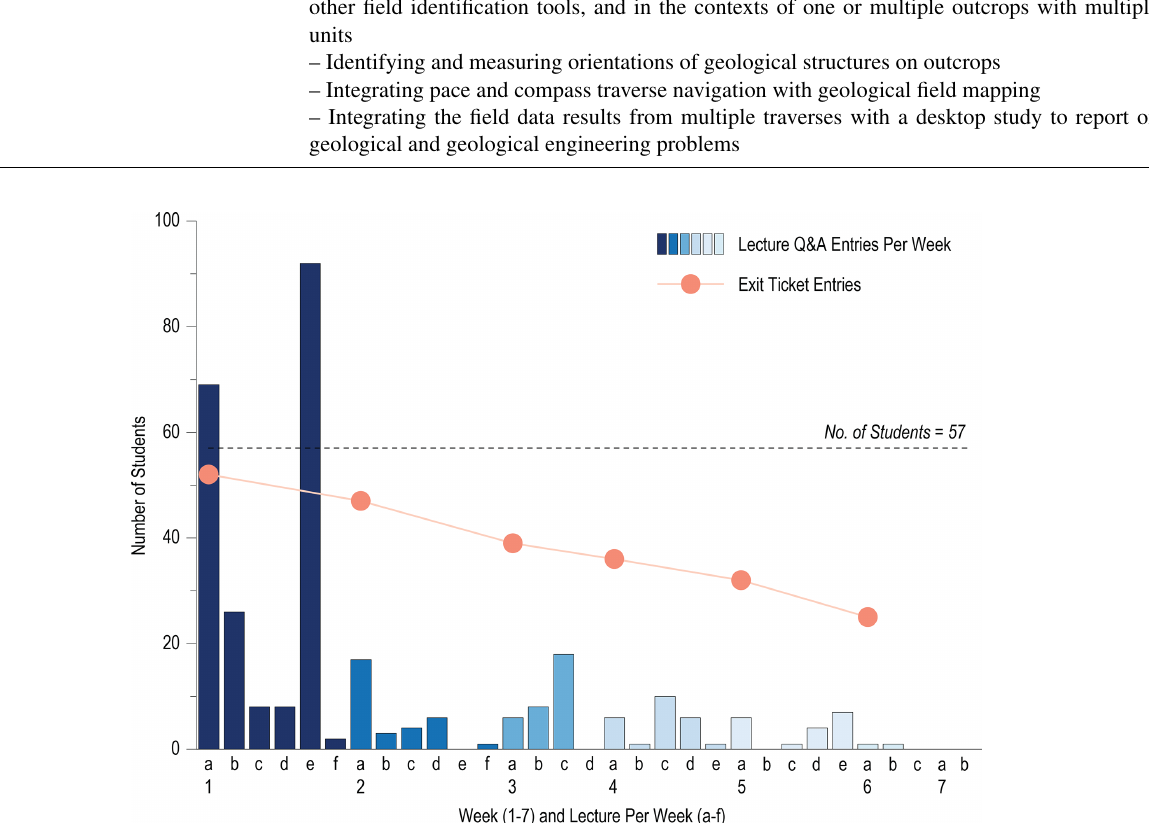
Figure 11. Student engagement in GEOE/L 221 during fall 2020 through lecture Q&A entries and weekly exit ticket